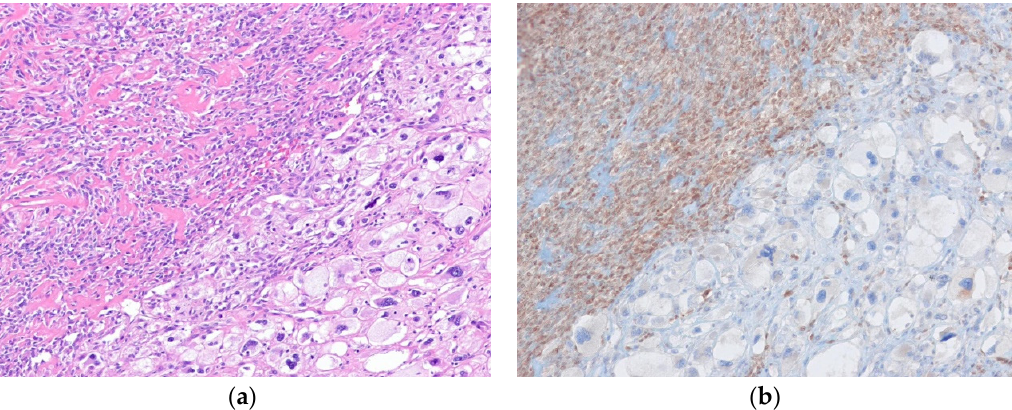
Figure 5. Dedifferentiated solitary fibrous tumor. ( a ) The tumor shows an abrupt transition from typical solitary fibrous tumor to high-grade dedifferentiated area. ( b ) The typical solitary fibrous area shows strong and diffuse positive nuclear expression of STAT6 and the dedifferentiated area shows loss of STAT6 expression (H&E stain, original magnification 100× a ; STAT6 immunostain, original magnification 100× b